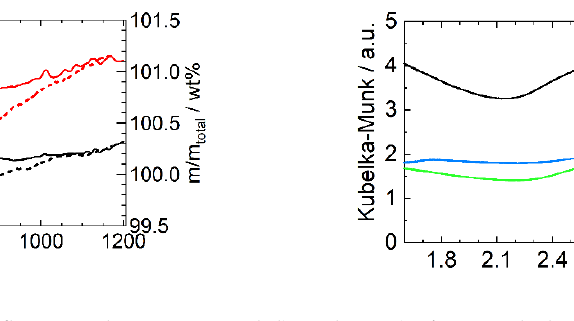
Figure 5. Left : DSC (heat flow, exothermic up, solid) and TG (m/m total , dashed) curves under forming gas (95% N 2 /5% H 2 ) for (d) C12A7e − (3C) shown in red and (a) C12A7 shown in black. 10 mg of sample each were heated with a rate of 10 K · min −1 from RT to 1173 K. The dotted blue lines indicate the region of the color change for C12A7e − as shown in Figure 4. Right : Kubelka–Munk-transformed DRUVVis spectra for (d) C12A7e − (3C) shown in black and the resulting powders after reactivity tests at 723 K under forming gas (blue) and N 2 (green). The dotted line at 2.83 eV corresponds to the absorption peak maximum for N e = 1 · 10 18 cm −3 [21]. The arrow indicates the shift with increasing N e .